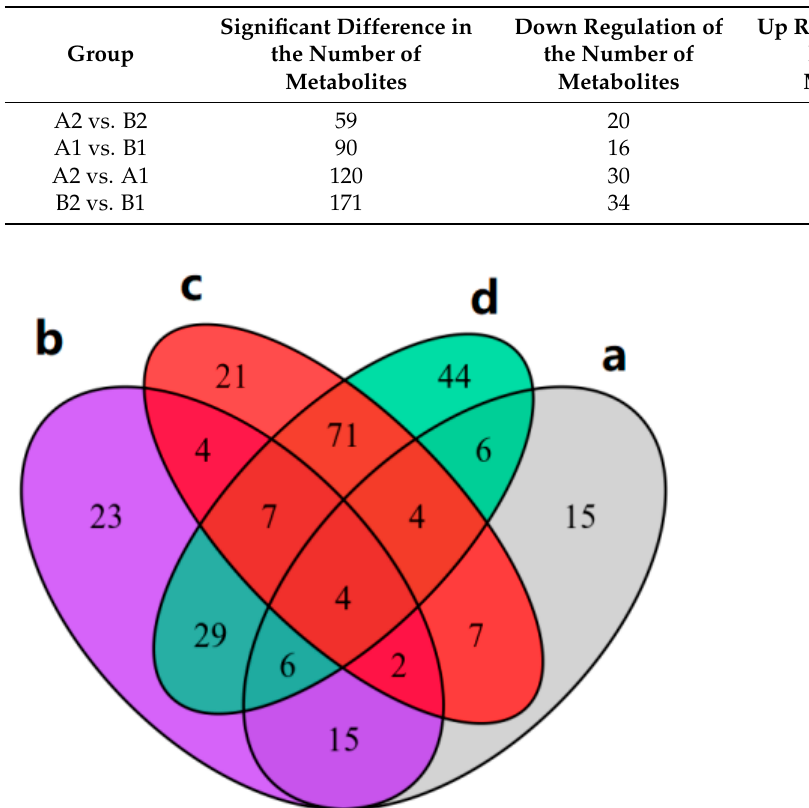
Table 2. Screening results of different metabolites.